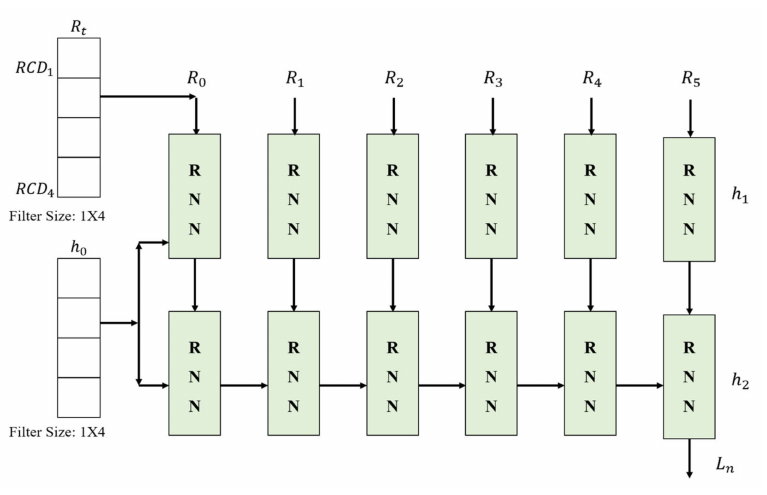
Figure 5. Proposed RNN based positioning network